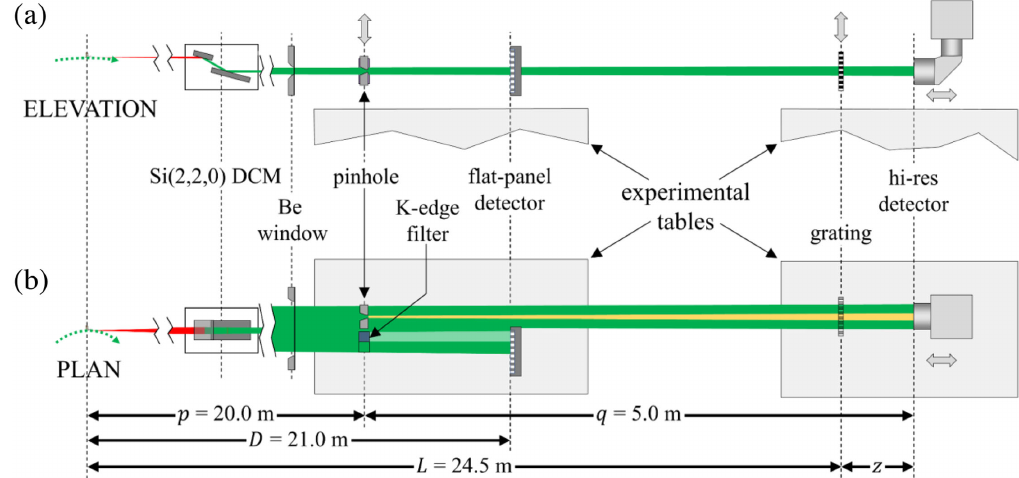
1. Schematic of the experimental setup at BMIT-BM beamline for measuring the source size with three different